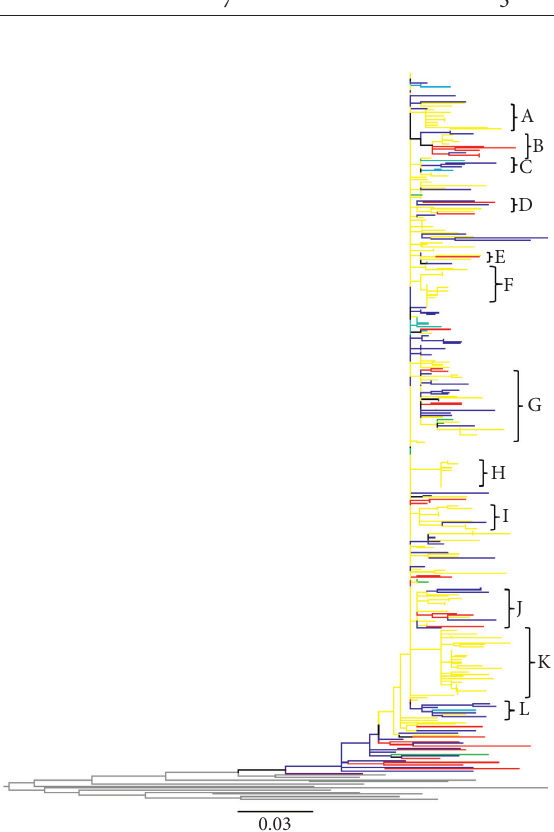
Figure 4: Phylogenetic relationship of HIV subtype A gag gene sequences from FSU countries: For the construction of the phy- logenetic tress, a stretch of HIV sequence corresponding to HBX2 nucleotide 859–1230 was used. The sequences are included from Belarus, Georgia, Kazakhstan, Latvia, Russia, Ukraine, and Uzbekistan. Color key is the same as for Figure